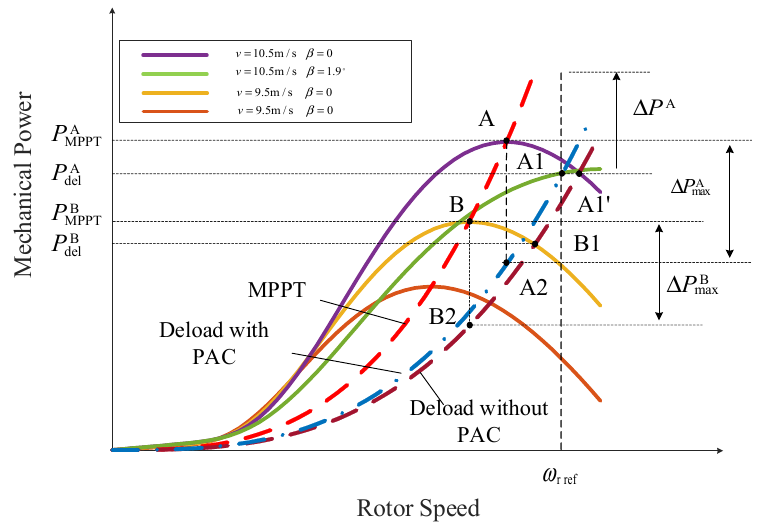
Figure 3. Principle of the cooperative deloading control.